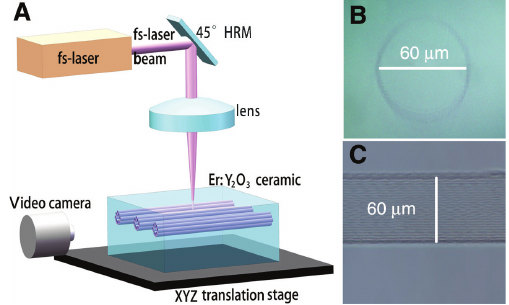
Figure 1: Experimental setup of femtosecond laser direct writing and optical microscope images of the waveguide. (A) The schematic of femtosecond laser direct writing in an Er:Y ceramic waveguide. (B and C) Optical microscope images of